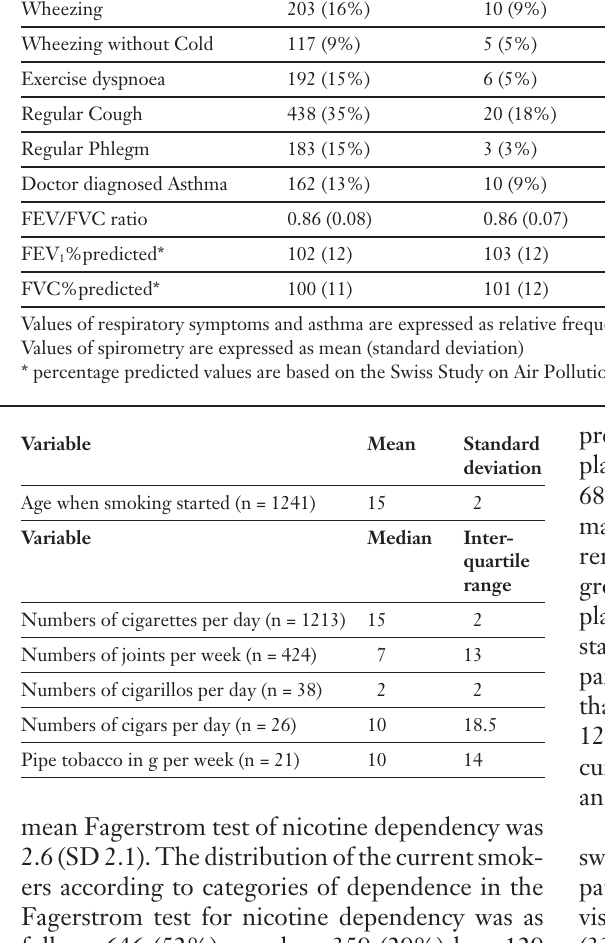
Table 2 Respiratory symp- toms, asthma and spirometry according to smoking status (n = 2604).